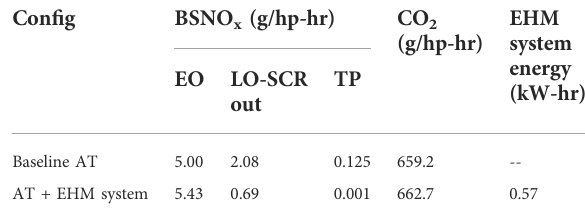
TABLE 11 Hot WHTC test